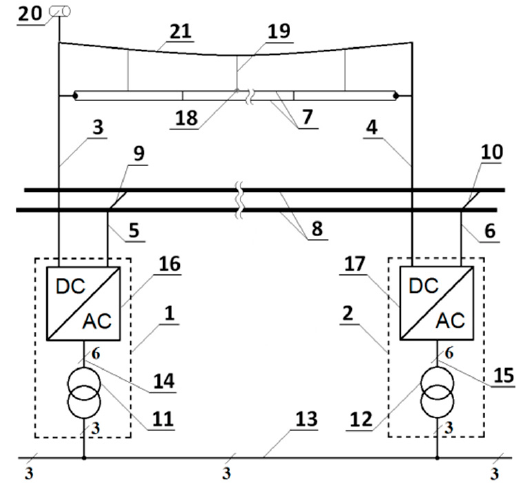
Figure 2. De-icing system with two supply stations.